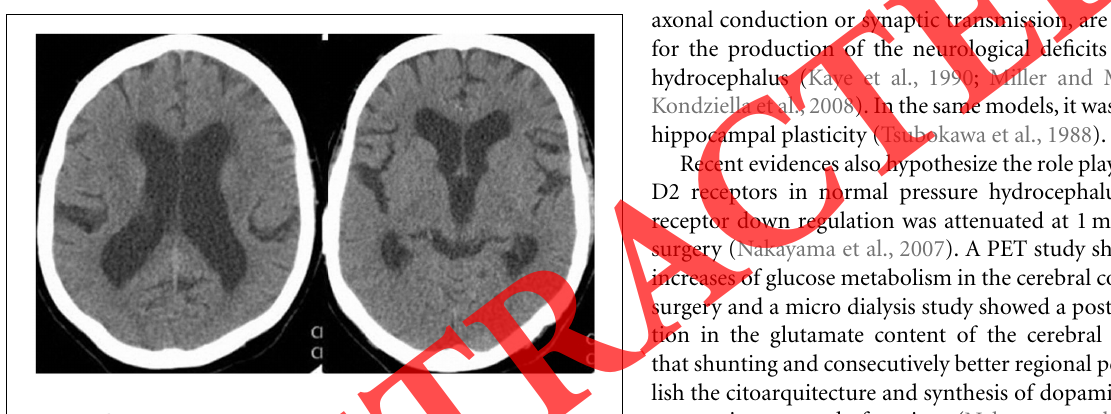
FIGURE 2 | Neuroimaging in normal pressure